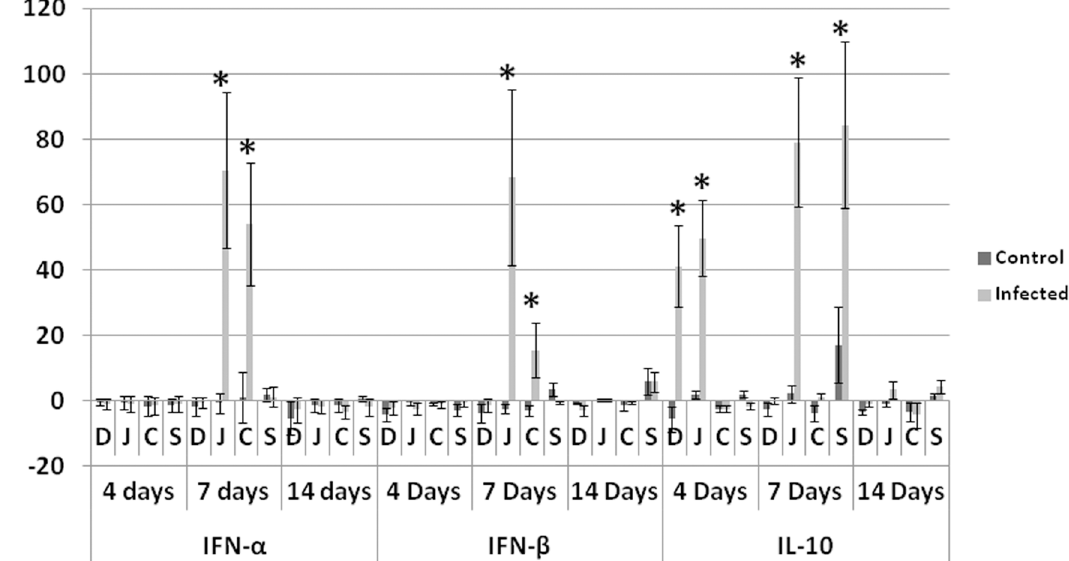
Fig 3. Fold change in antiviral cytokines (IFN- α and IFN- β ) and anti-inflammatory IL-10. At 7 dpi IFN- α and IFN- β in jejunum and cecum of infected birds were significantly elevated. IL-10 is significatnly elevated in duodenum and jejunum of infected birds at 4 dpi and in jejunum and spleen of infected birds at 7 dpi. D : duodenum, J : jujenum, C : cecum, S spleen, Days refers to days post inoculation (dpi). * Analyses were performed in duplicate (Five turkeys/group at each time point) and values are mean ± 3SD. Differences between the infected and non-infected groups within the same organ are significant (P < 0.05).